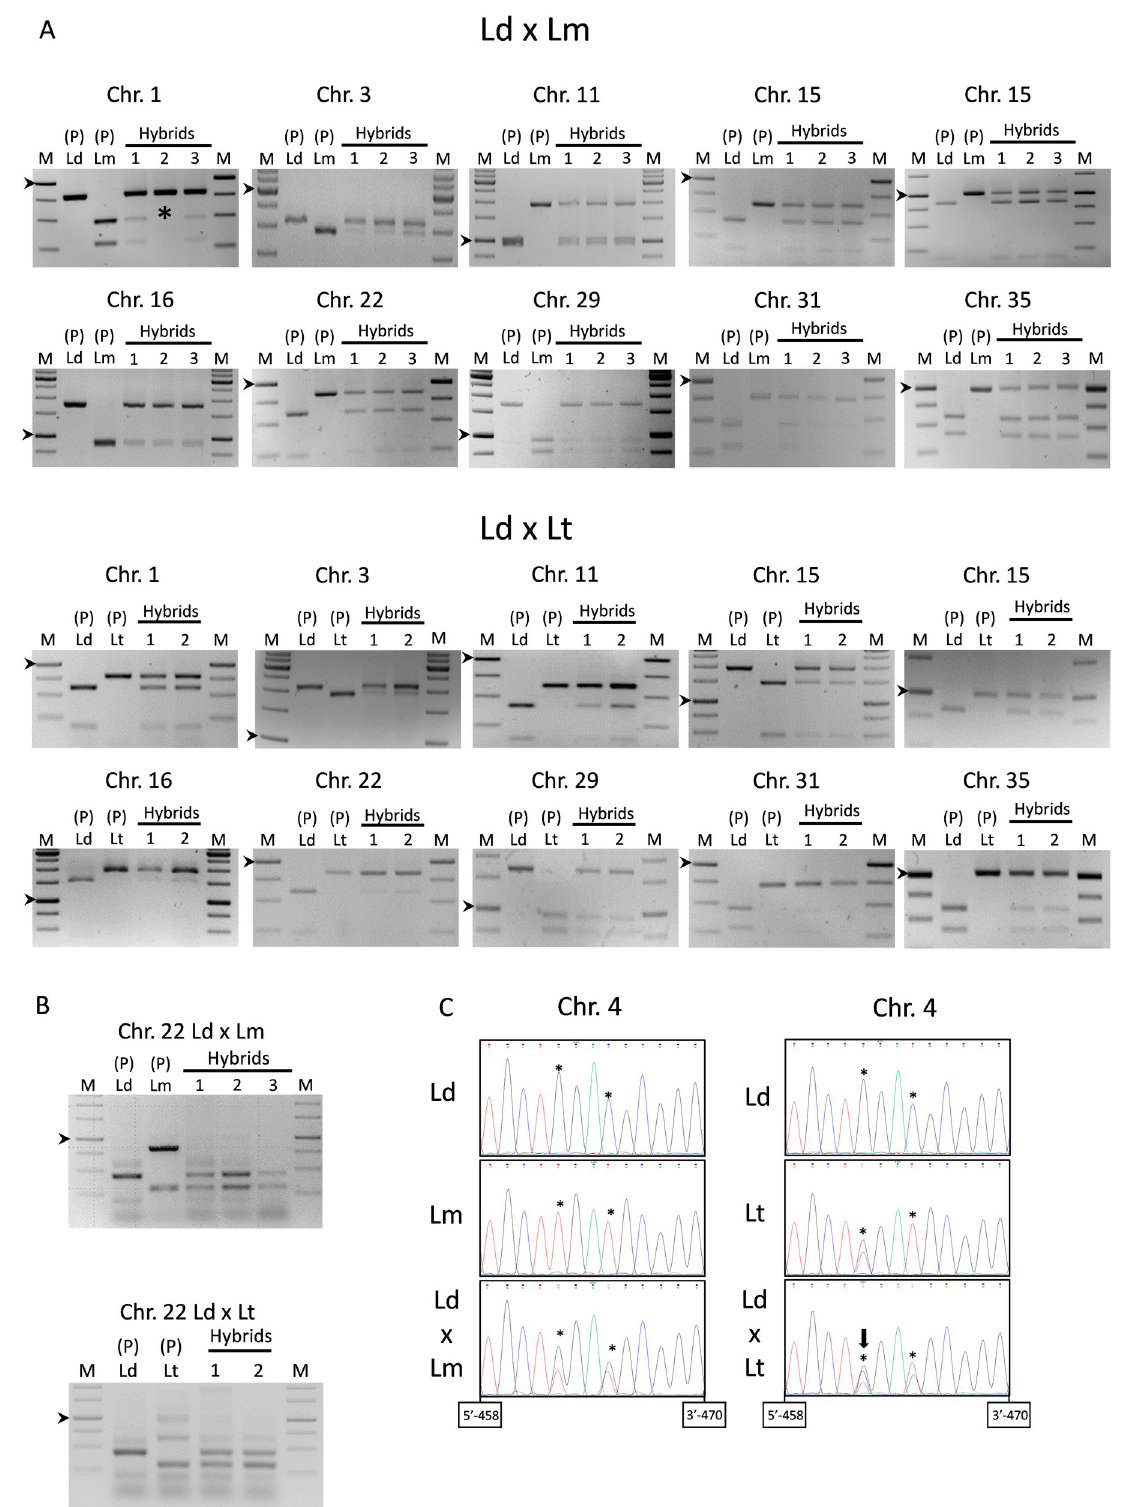
Fig 5. Characterization of the nuclear inheritance of the interspecies hybrids. (A) Agarose gels of the SNP-CAPs analysis showing the DNA products after PCR amplification and enzymatic digestion of the ten genes present in nine different chromosomes. The electrophoretic profile of the parental lines [P (Ld, Lm)] and three hybrids [Hybrids (1, 2, 3)] resulting from the outcrossing of L